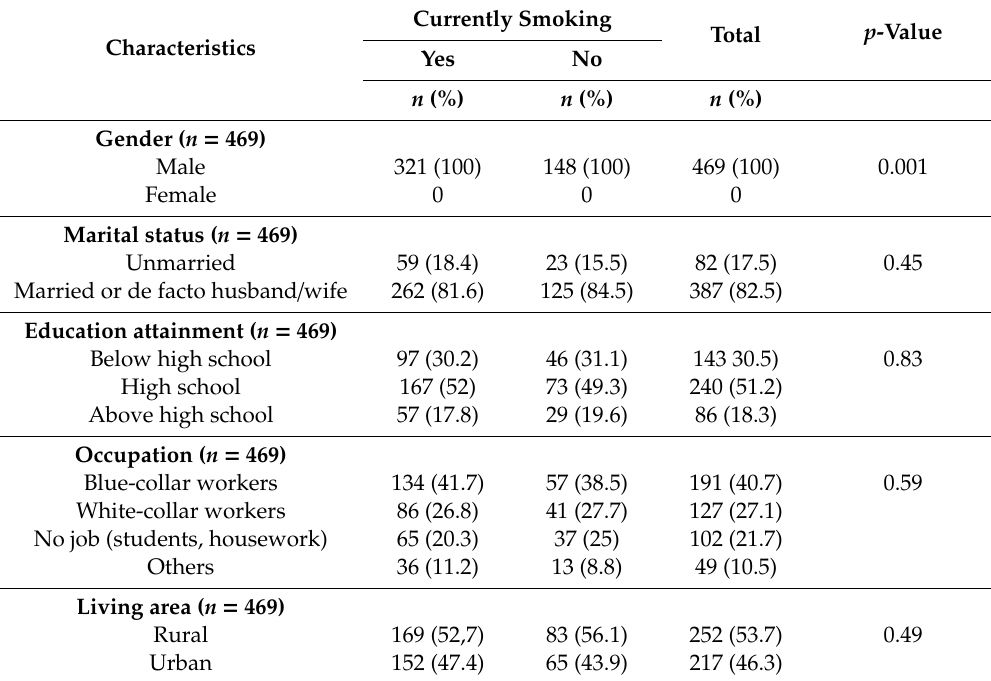
Table 1. Sample characteristics by smoking status ( n =